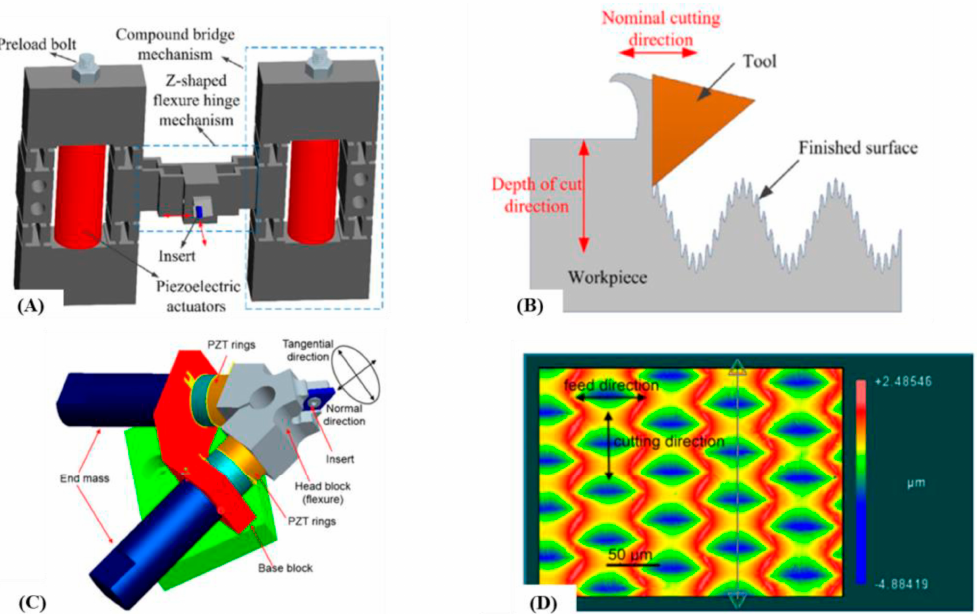
Figure 23. CM-based ultraprecision texturing tools. ( A ) 2D vibration assisted cutter and its ( B ) ma- chined hierarchical surface. As the tool cuts out the larger sinusoidal freeform surface at a slower frequency with one piezoelectric actuator, the other actuator drives the cutting insert at a higher frequency but smaller depth of cut to produce the micro/nano microstructures on the sinusoidal surface [160]; ( C ) 2DOF elliptical vibration texturing tool and its ( D ) dimpled microtextured sur- face